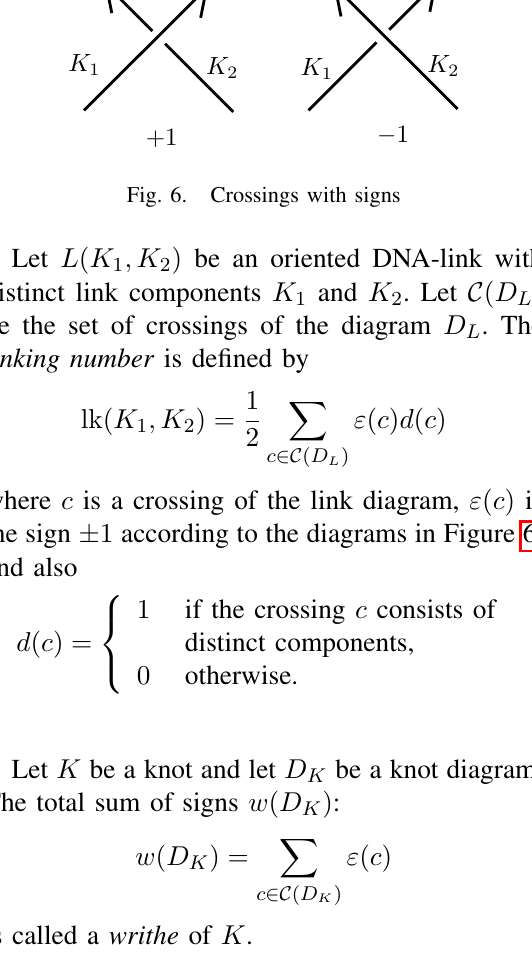
Fig. 7. Unknotting operation in mathematical